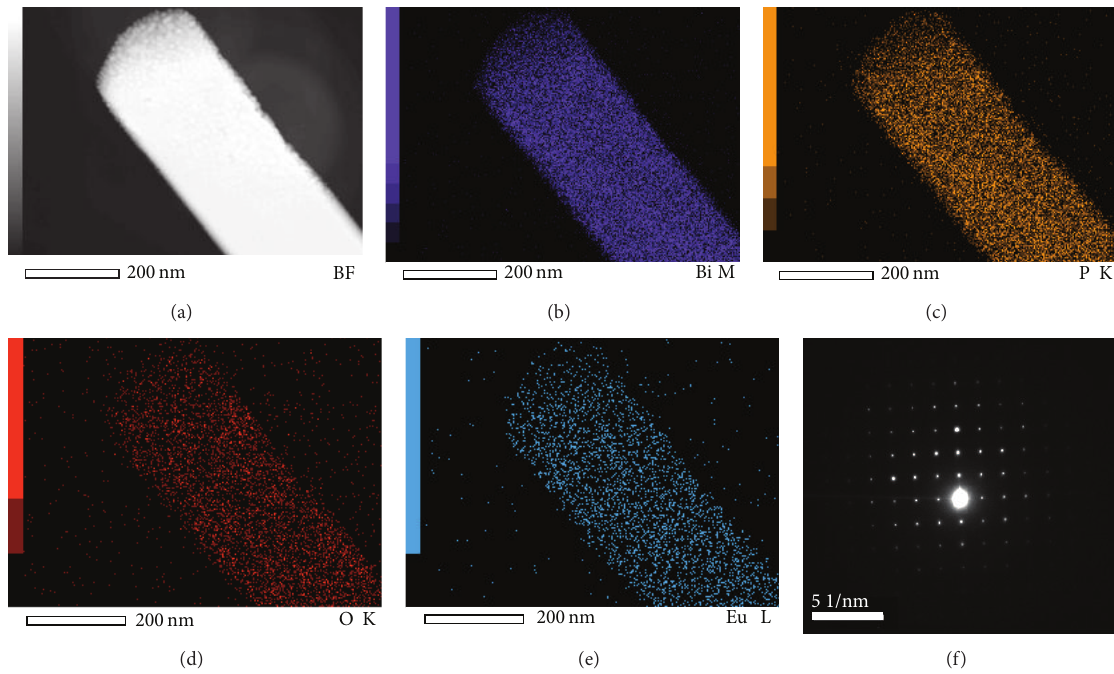
Figure 3: (a) Bright field TEM micrograph of the 1.0mol% Eu 3+ doped sample, (b) to (e) EDAX elemental mapping of Bi, P, O, and Eu. (f) Corresponding selected area electron diffraction pattern (SAED) with scale bar 5 nm.